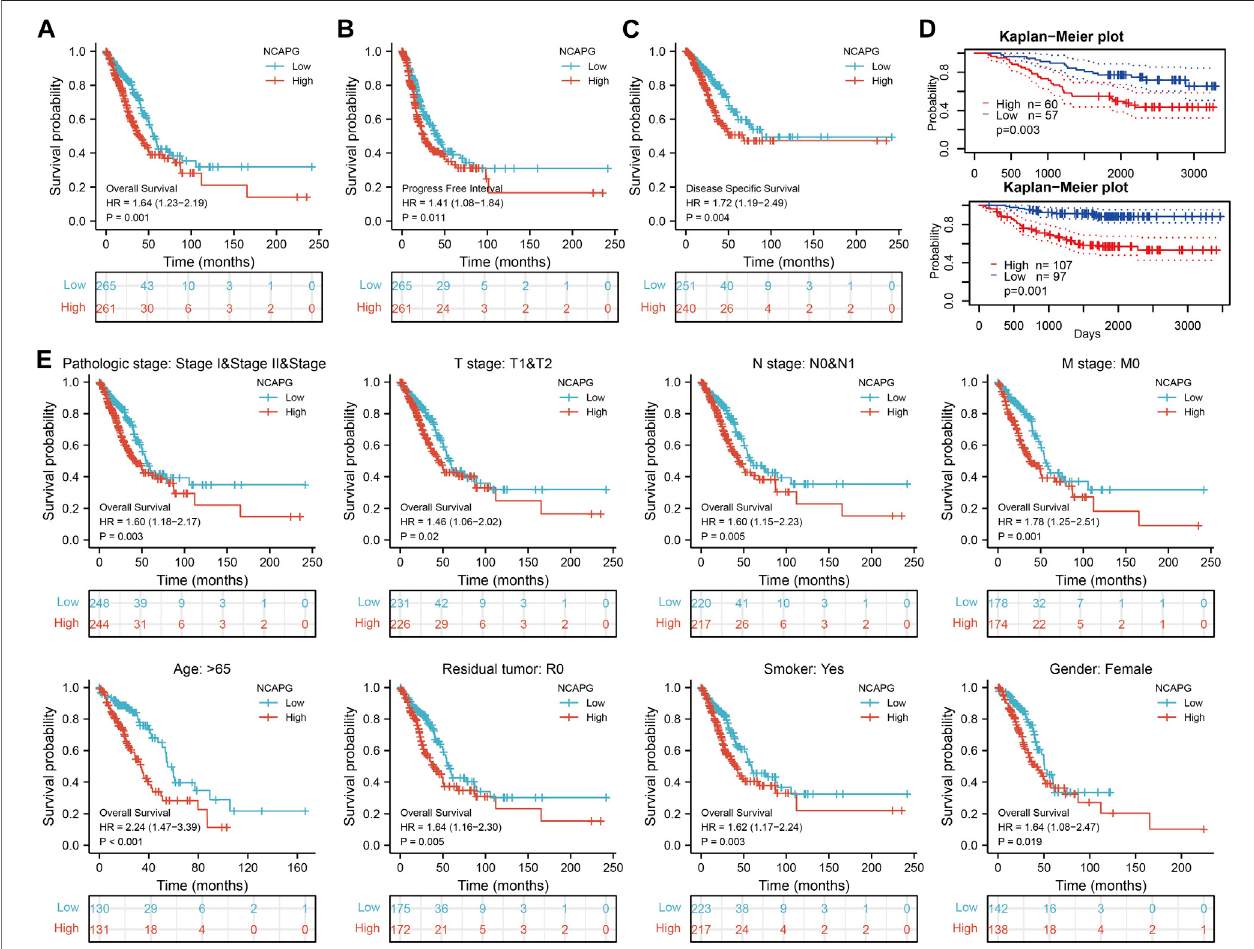
FIGURE 3 | The prognosis of NCAPG in NSCLC. (A – C) The prognosis of NCAPG in NSCLC is examined by the TCGA database. (D) The prognosis of NCAPG in NSCLCisexaminedbytheGEOdatabase. (E) Distinctclinicaloutcomes basedonNCAPG expressioninNSCLCpatient subgroups.* p < 0.05,** p < 0.01,*** p < 0.001.